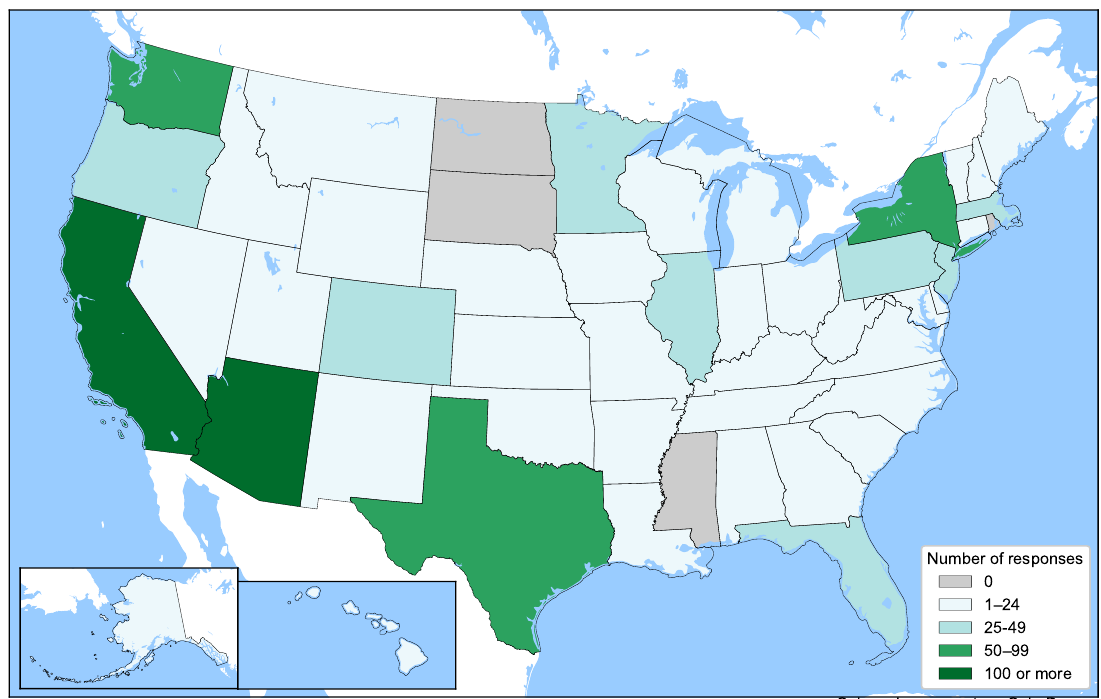
Figure 2. Number of responses by